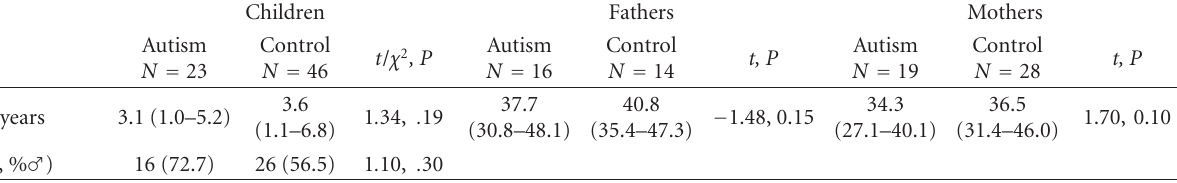
Table 2: Participant characteristics.